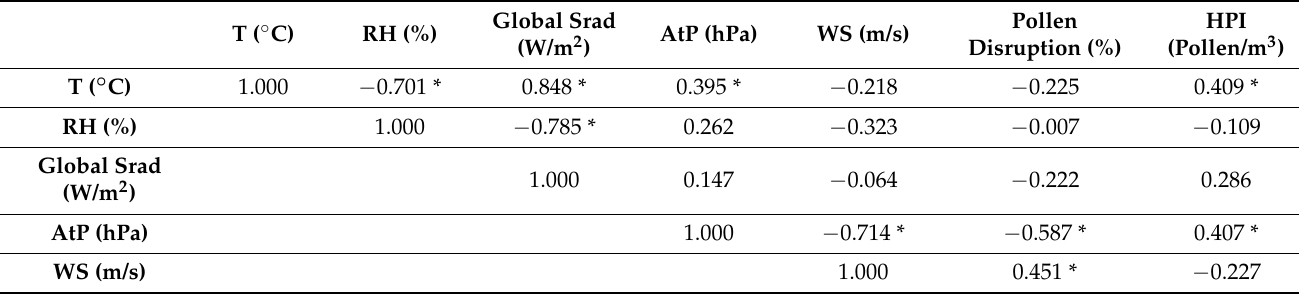
Table 6. Pearson’s correlation between hourly meteorological parameters and hourly disrupted pollen (%) hourly total pollen (m 3